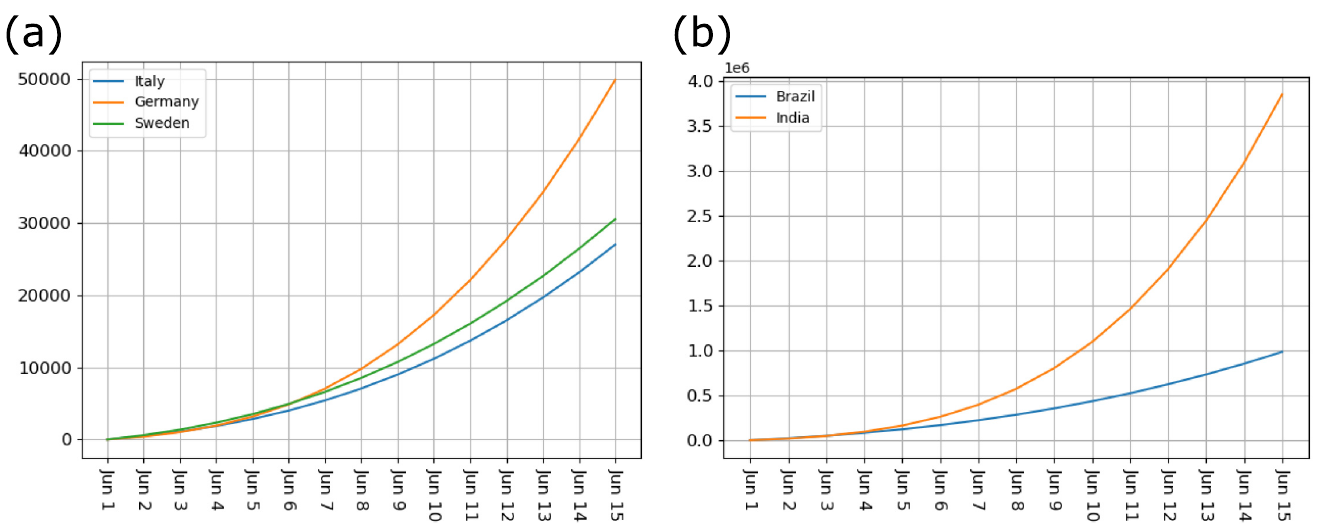
Fig 4. New outbreak. (a) new outbreak in Italy, Germany and Sweden, (b) new outbreak in India and Brazil.